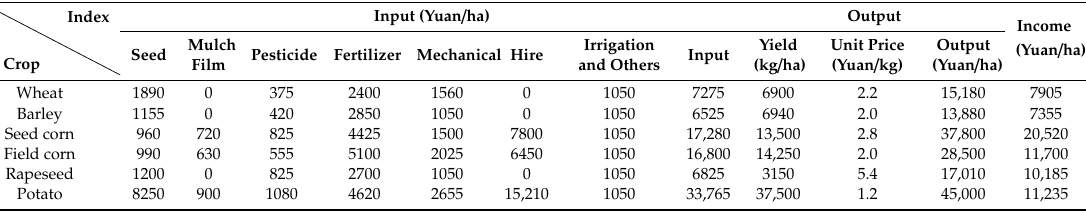
Table 3. Main crop input–output tables in the study area.